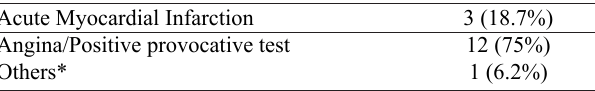
Table 2. Clinical characteristics of the patients. Acute Myocardial Infarction Angina/Positive provocative